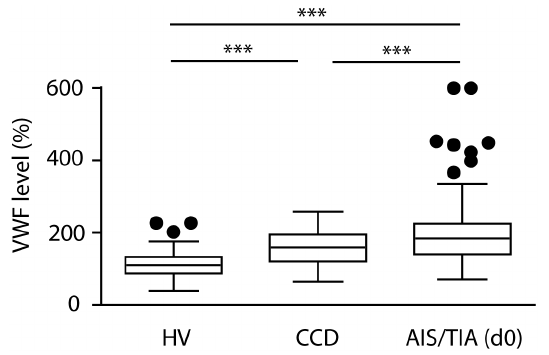
Figure 1. von Willebrand factor (VWF) levels in acute ischemic stroke (AIS)/transitory ischemic attack (TIA), chronic cerebro- vascular disease (CCD), and healthy volunteers (HV). The VWF levels are depicted in box-and-whisker plots indicating the first and third quartiles as well as the 1.5 interquartile range (IQR, Tukey plot). Outliers outside 1.5 IQR are visualized by single dots. VWF levels showed significant differences between the three groups. Analysis of variance with Bonferroni post hoc test, *** P , 0.001. d0=day